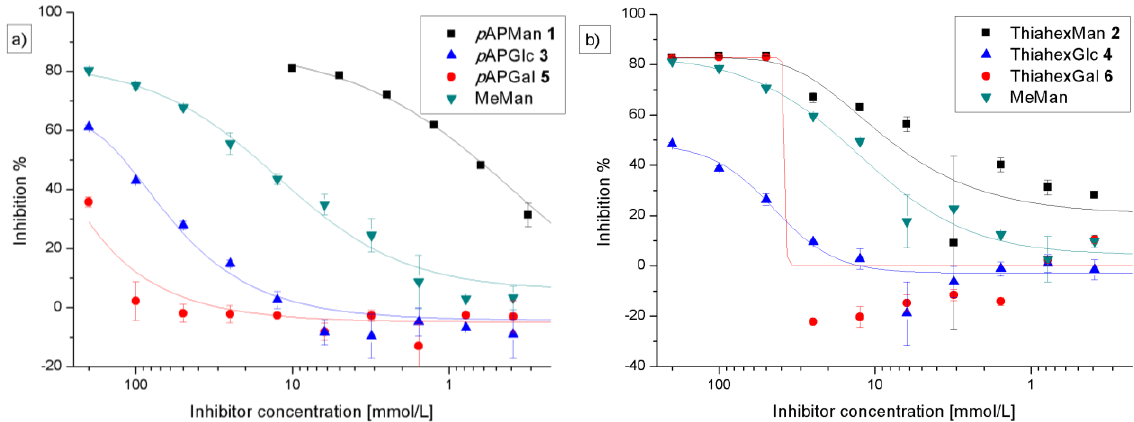
Figure 5. Inhibition curves obtained with the phenyl glycosides 1 , 3 , and 5 ( a ) and the alkyl glycosides 2 , 4 , and 6 ( b ) as inhibitors for type 1 fimbriae-mediated bacterial adhesion to mannan. The depicted inhibition curves are representative examples from several (>3x) independent experiments. The standard inhibitor MeMan was tested simultaneously on each plate. Error bars result from duplicate values on one plate.